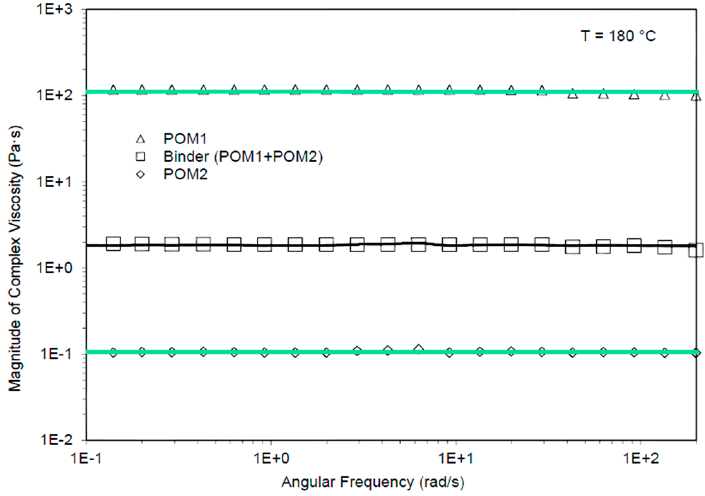
Figure 2. Viscosity of POM-based binder and its components at 180 °C. Components were fitted (line) by their average value and binder with the van der Wyk model.